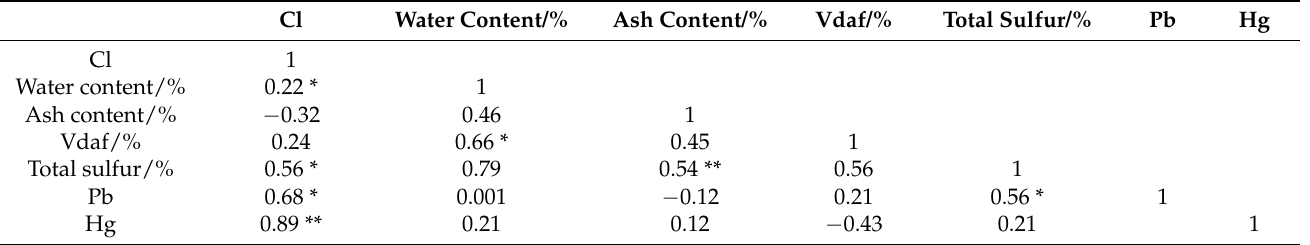
Table 4. Person Correlation Analysis between Cl and Coal Quality in Coal.